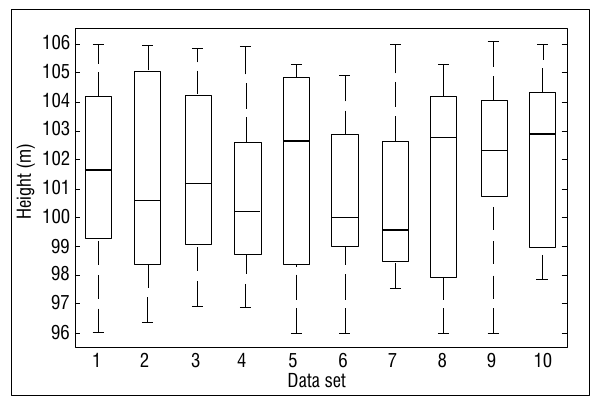
The inner lines of the box indicate the median of the data. The top of the upper tail indicates the highest value of the data, while the bottom of the lower tail indicates the lowest value of the data. Figure 4: Box plots of the 10 data sets of 20 sample points each.